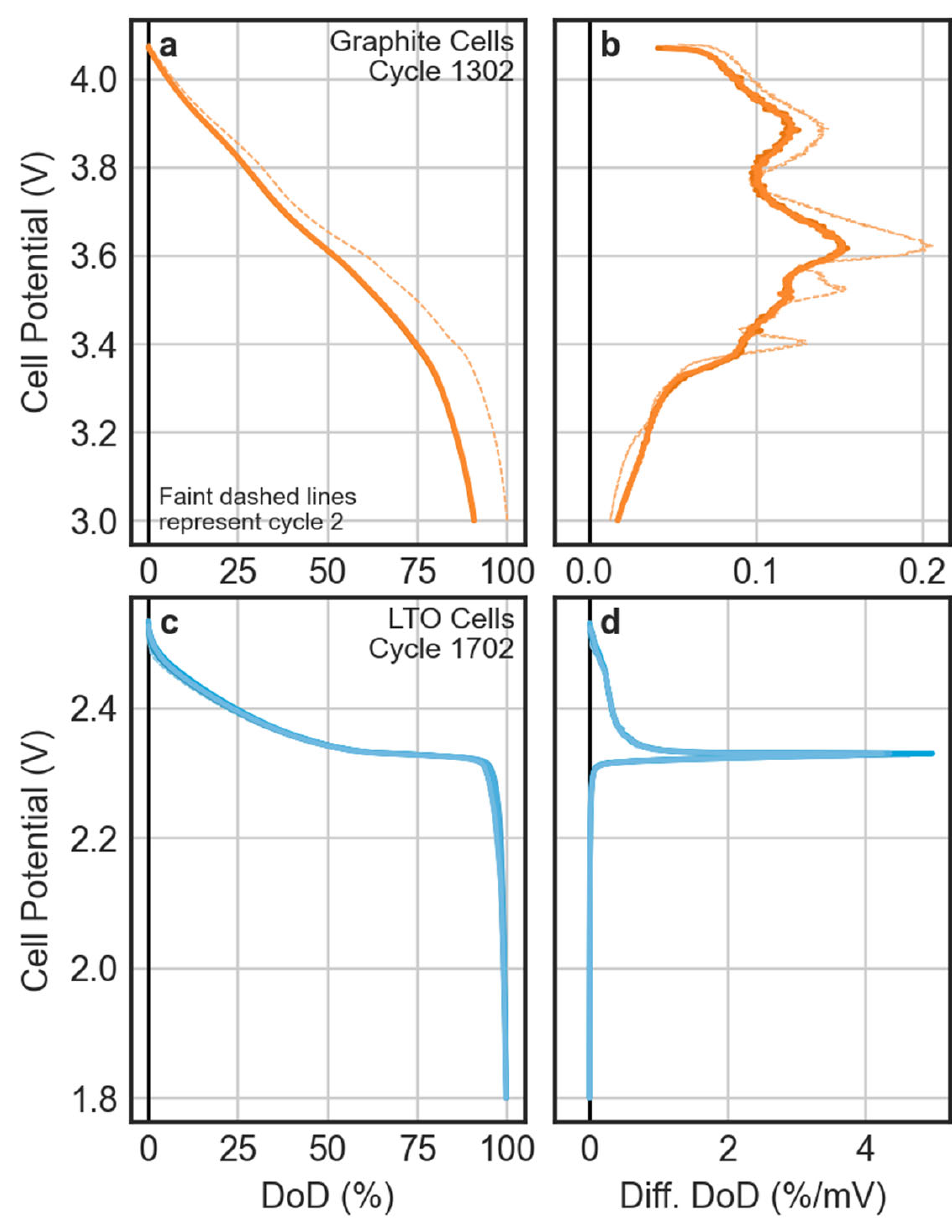
Figure 2. Cell potential vs. depth-of-discharge (DoD; ( a , c )) and differential DoD ( b , d ) for the graphite ( a , b ) and lithium titanium oxide (LTO) ( c , d ) cells, during selected C/24 discharges. DoDs are normalized to the initial C/24 discharge capacity for each cell. The differential capacity plots include faint dashed lines that show the initial cycle performance. These are covered by other lines on the LTO differential capacity plot.